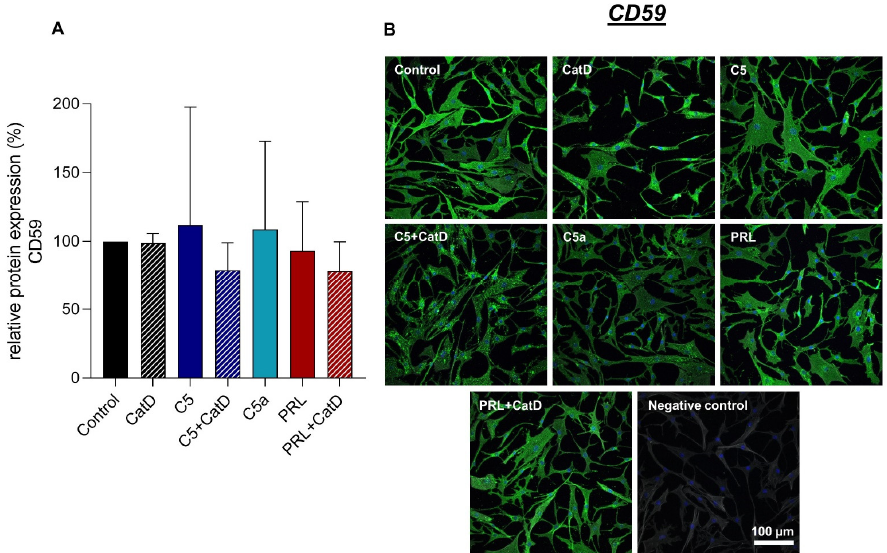
Figure 7. Chondrocytes protein expression of CD59 after 72 h of stimulation and negative control of the staining. n = 3 independent experiments with chondrocytes from different donors. ( A ): Graphic representation of relative CD59 protein fluorescence intensity, mean with standard deviation. Control has been normalized to 1. One sample t-test with significance in relation to control. Mixed-effects analysis using post-hoc Tukey’s multiple comparisons. ( B ): representative images of chondrocytes immunolabeled with CD59 specific antibodies. Green (Alexa Fluor 488) = CD59, blue (DAPI) = cell nuclei, grey (Phalloidin Alexa 633) = Actin cytoskeleton. Scale bar = 100 µ